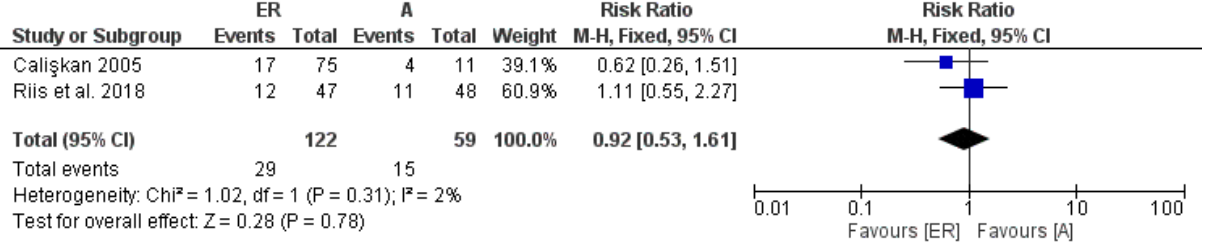
Figure 5. Forest plot of the fixed-effects model of the meta-analysis of the failure data within the 8–10-year follow-up. RR 0.92 [ 0.53, 1.61] Chi 2 = 0.85, df = 2 ( p = 0.66).